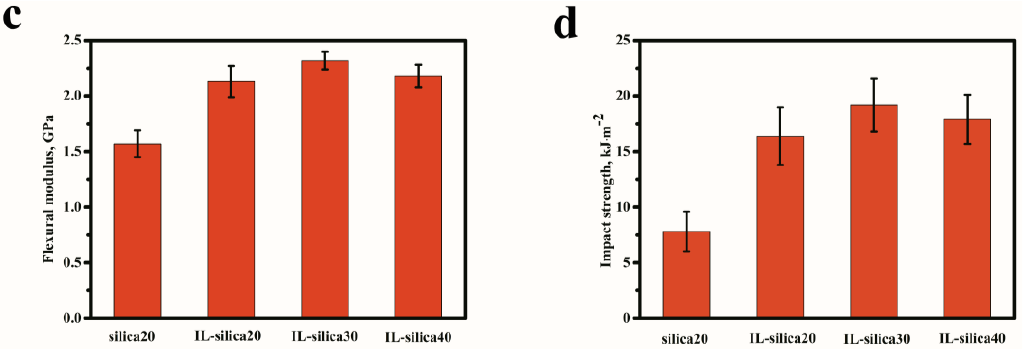
Figure 5. Mechanical properties of epoxy composites containing u-silica and IL-silica. ( a ) Tensile strength; ( b ) Flexural strength; ( c ) Flexural modulus; ( d ) Impact strength.